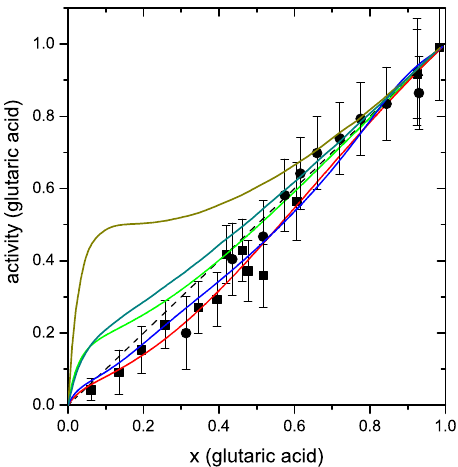
Fig. 2. Glutaric acid activity versus mole fraction of glutaric acid. Data at T = 290 . 9K: (cid:4) , T = 281 . 3K: , T = 303 . 2K: N . Dotted line: Raoult’s law; Dark yellow line: UNIFAC Dortmund param- eterization taken from Koponen et al. (2007); Dark cyan line: van Laar parmeterization by Koponen et al. (2007); Green line: UNI- FAC parameterization by Ming and Russell (2002); Blue line: pa- rameterization by Clegg and Seinfeld (2006a) ∗ ; Red line: UNIFAC parameterization by Peng et al. (2001). Mole fractions are on the ba- sis of undissociated glutaric acid. ∗ The Eqs. (5a) and (b) of Clegg and Seinfeld (2006a) contain several errors leading to large devia- tions especially for malonic acid. The coefficients given in Table 4 of Clegg and Seinfeld (2006a) are correct as they were estimated with the correct expressions (personal communication with Simon Clegg). The correct expressions are given in the Appendix A.